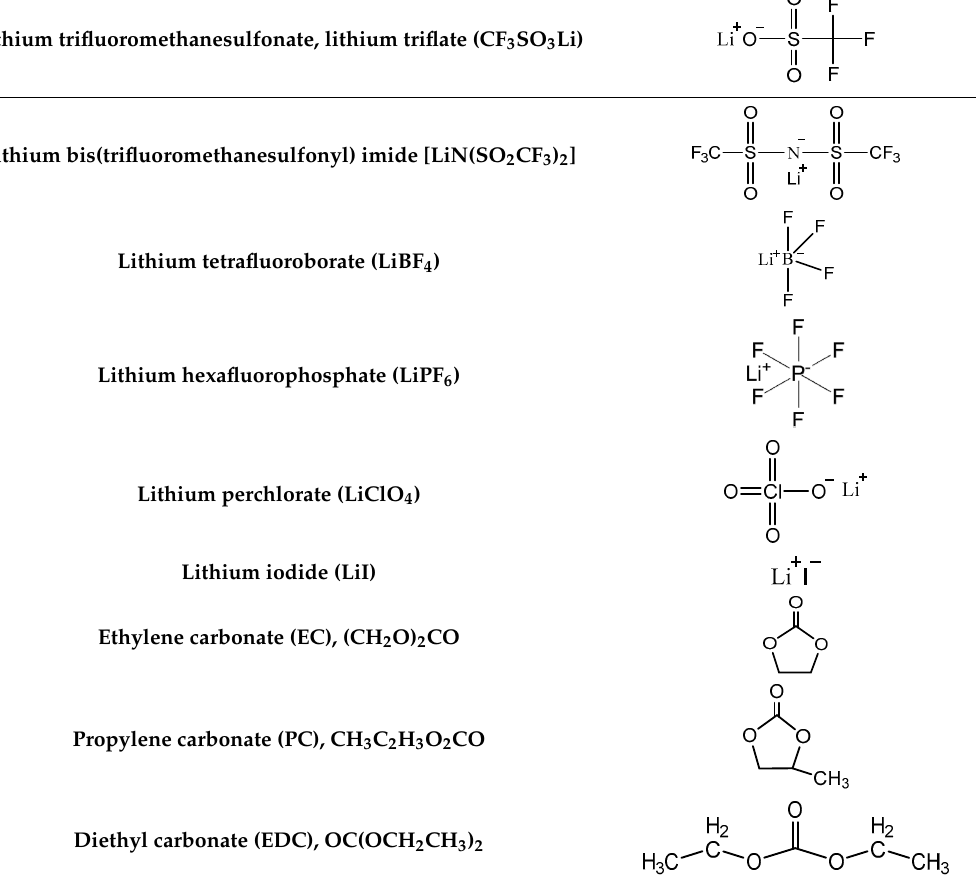
Table 6. Chemical structures of lithium salts and organic solvents mentioned in this review.